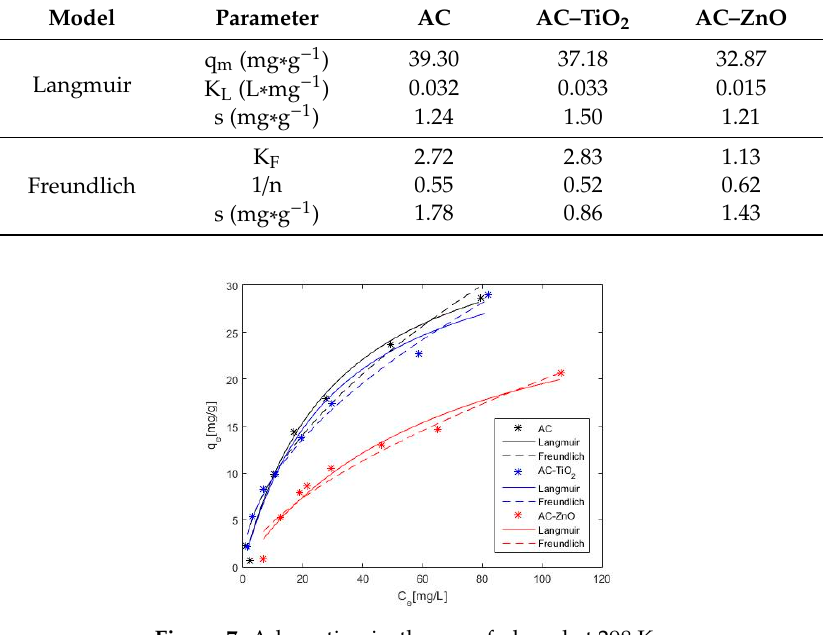
Table 2. Parameters calculated for Langmuir and Freundlich isotherm models. Figure 6. From left to right, DRS spectra and Tauc’s plot.